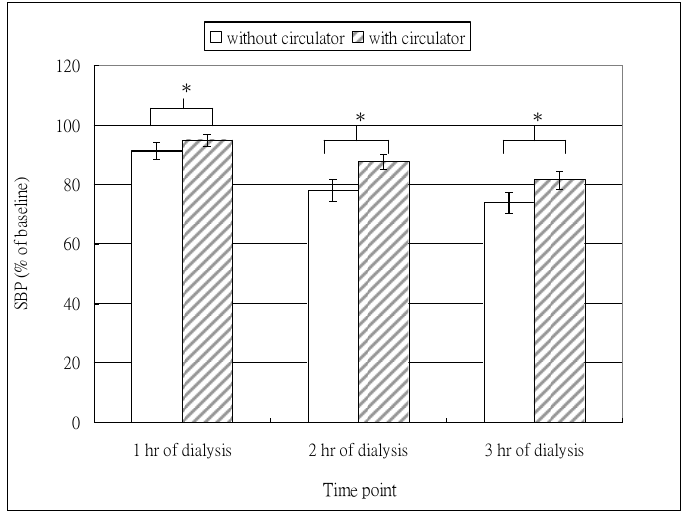
Figure 2. Mean and standard errors of SBP, DBP, and HR at different time points: (a) SBP; (b) DBP; (c) HR. (*A significant level was set at